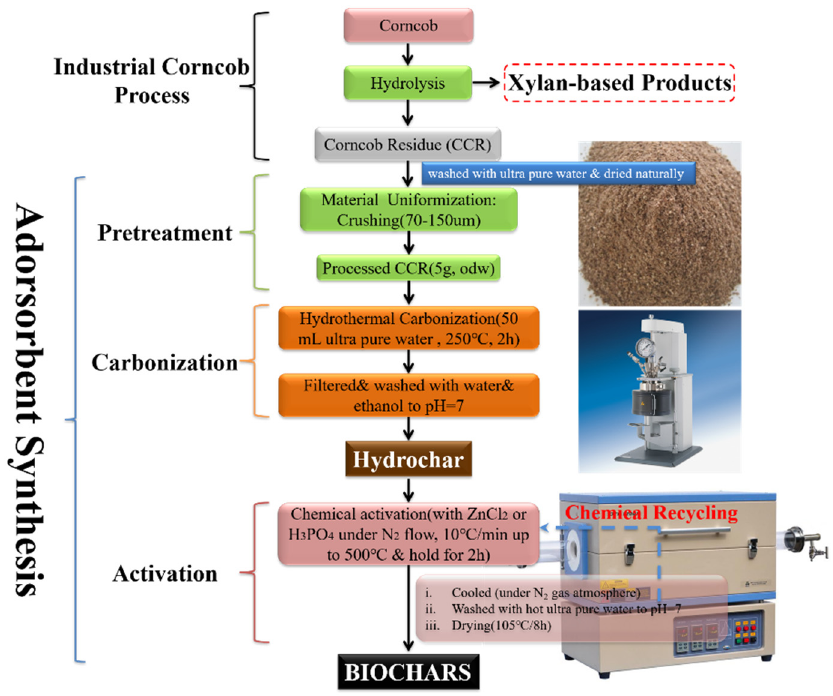
Figure 1. Synthesis procedures for preparing biochar (BC) samples: BC-ZnCl 2 and BC-H 3 PO 4 .